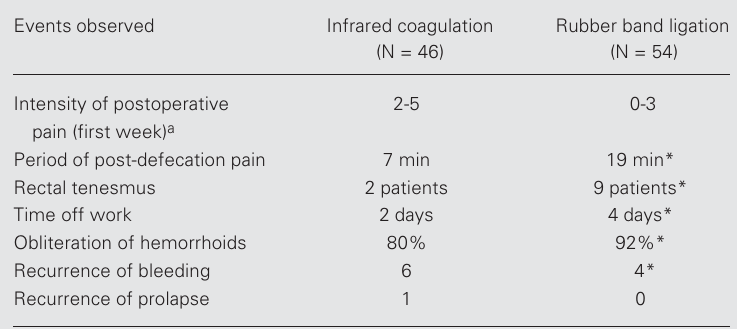
Table 2. Comparison of infrared coagulation and rubber band ligation in early stage